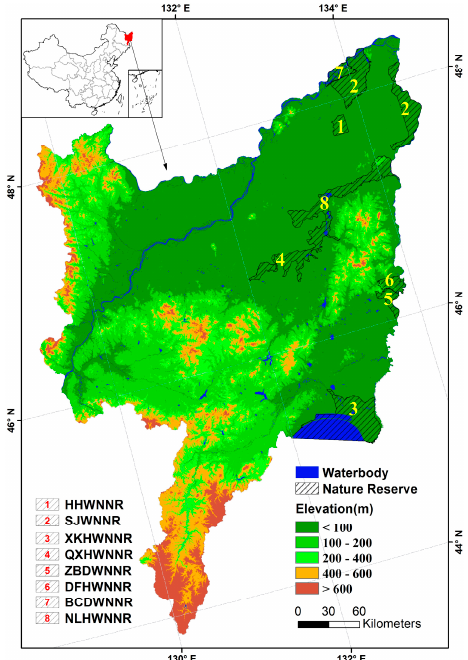
Figure 1. Terrain variation and the distribution of eight Wetland National Nature Reserves (WNNR) in the Sanjiang Plain.